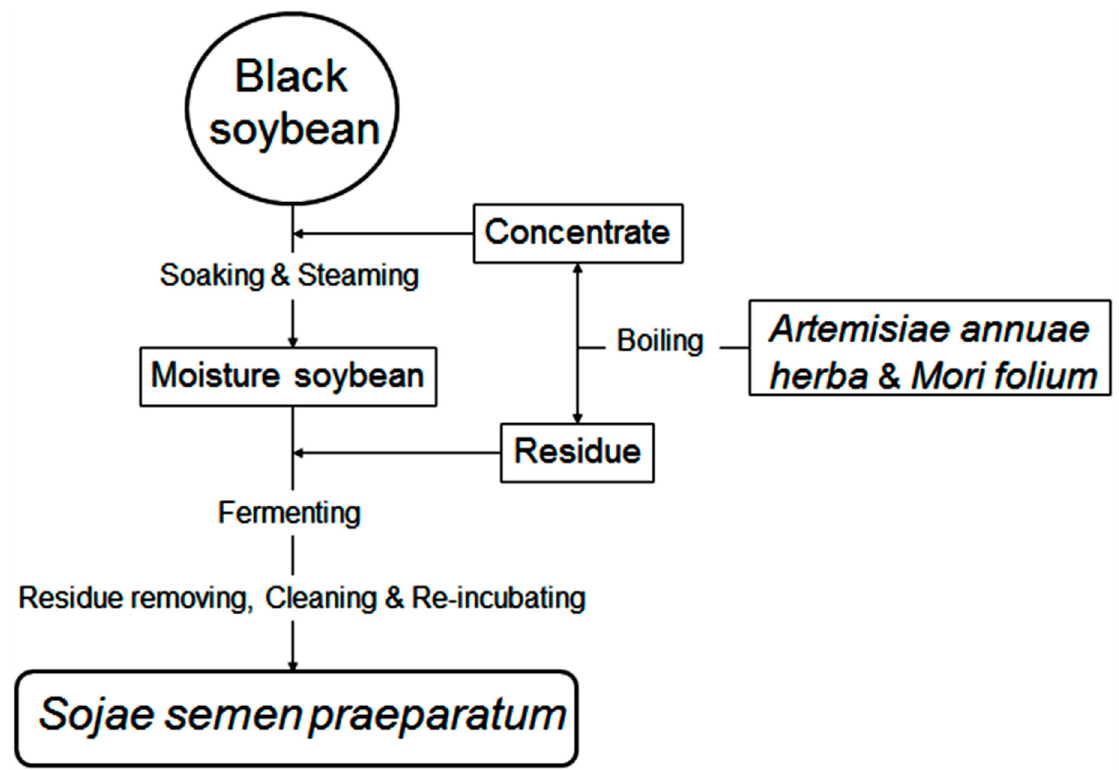
Figure 7. Flow diagram for fermentation of soybean to Sojae semen praeparatum (SSP).